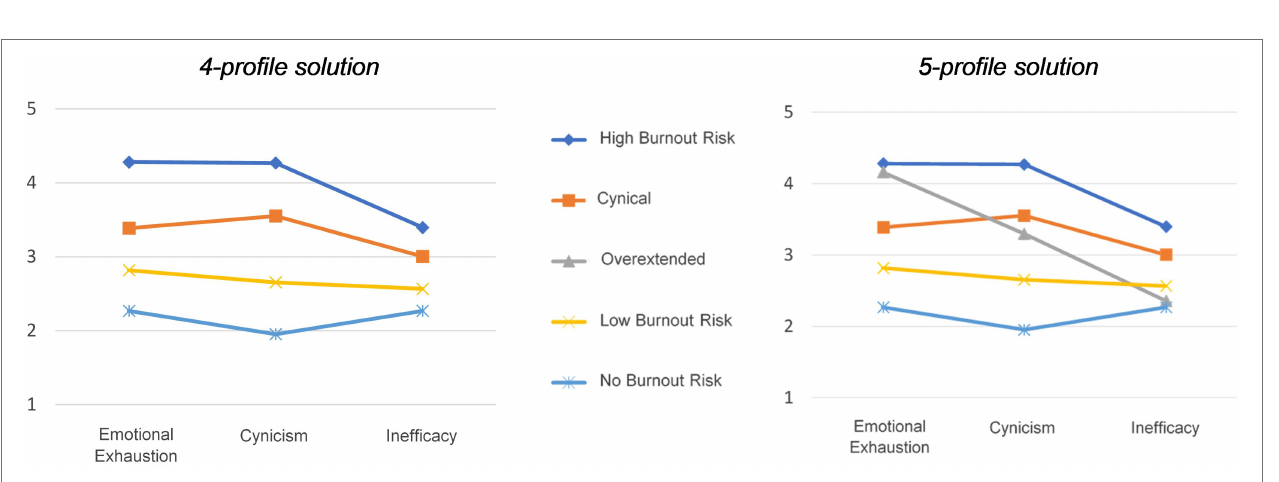
FIGURE 2 | Latent profiles of burnout: 4-profile solution and 5-profile